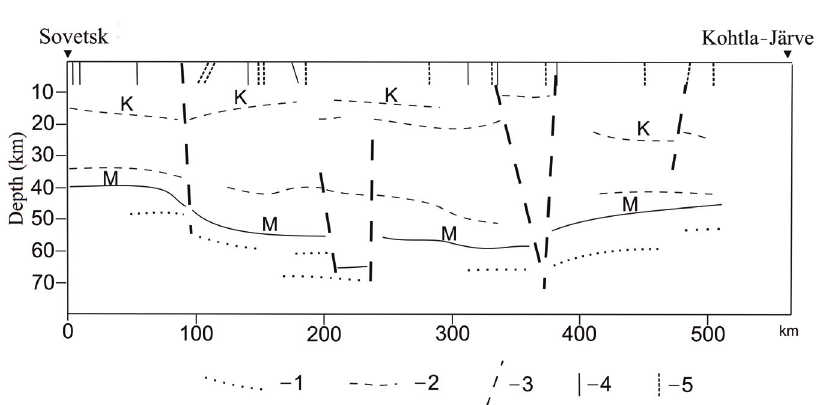
Fig. 1. Sovetsk–Kohtla­Järve seismic profile (redrawn from Ankudinov et al. 1994). M, Moho discontinuity; K, Conrad discontinuity; 1, boundary between layers in the upper mantle; 2, boundary between layers in the Earth’s crust; 3, faults crossing the entire Earth’s crust; 4, faults crossing the sedimentary rock cover and crystalline basement; 5, faults observed in the crystalline